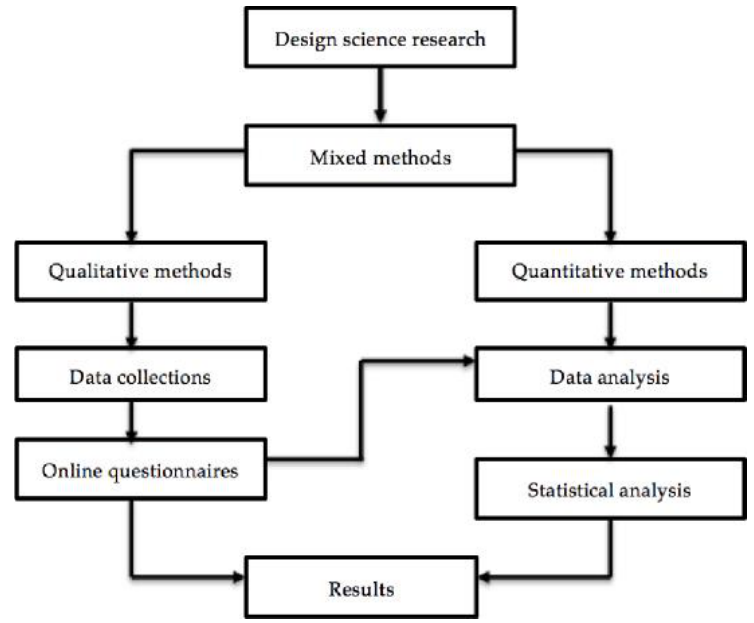
Fig. 1. Conceptual framework of the research methodology